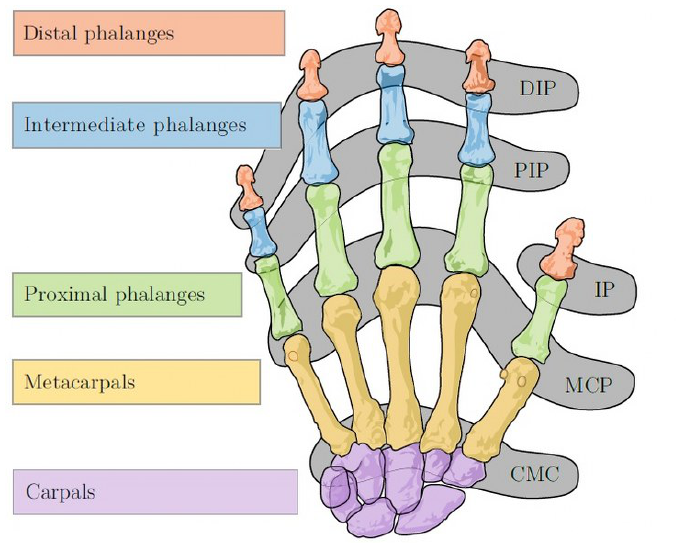
Figure 1. Bones and joints of the human hand, DIP—Distal Interphalangeal joint; PIP—Proximal Interphalangeal joint; IP—Interphalangeal joint; MCP—Metacarpophalangeal joint; CMC—Carpo-Metacarpal joint [27].